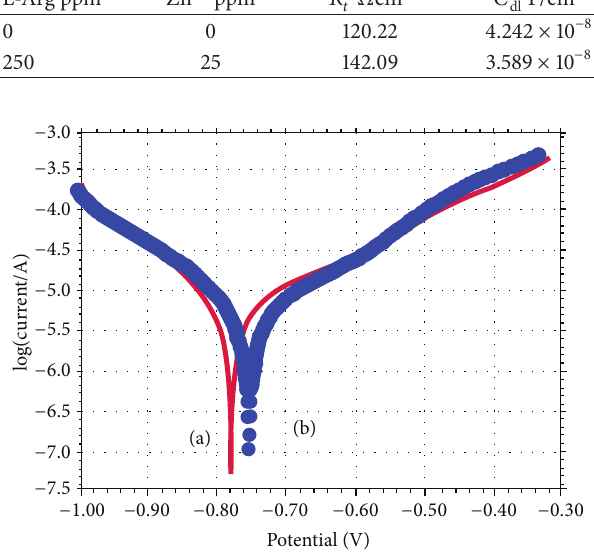
Figure 1: Polarization curves of carbon steel immersed in various test solutions. (a) Sea water. (b) Sea water + 250 ppm of L-Arg + 25 ppm of Zn 2+ .